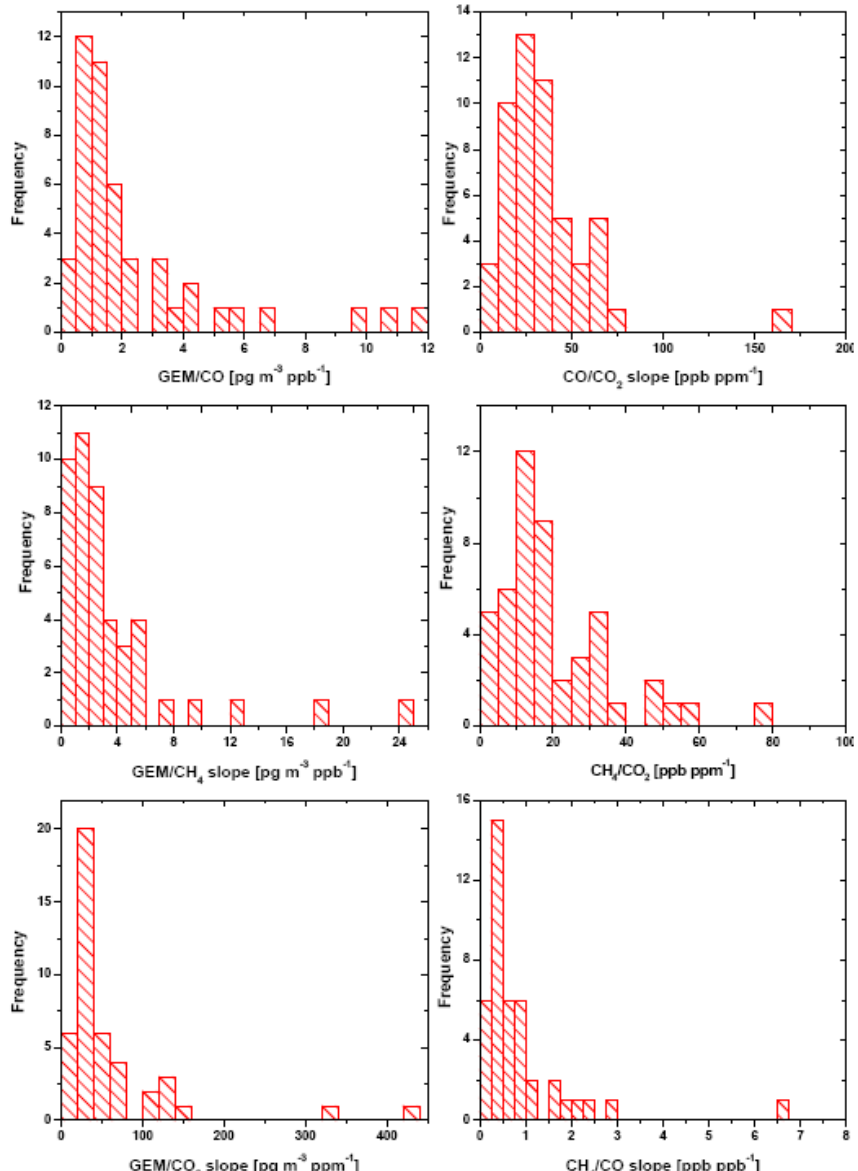
Fig. 2. Frequency distribution of GEM/CO, GEM/CO 2 , GEM/CH 4 , CO/CO 2 , CH 4 /CO 2 , and CH 4 /CO slopes.